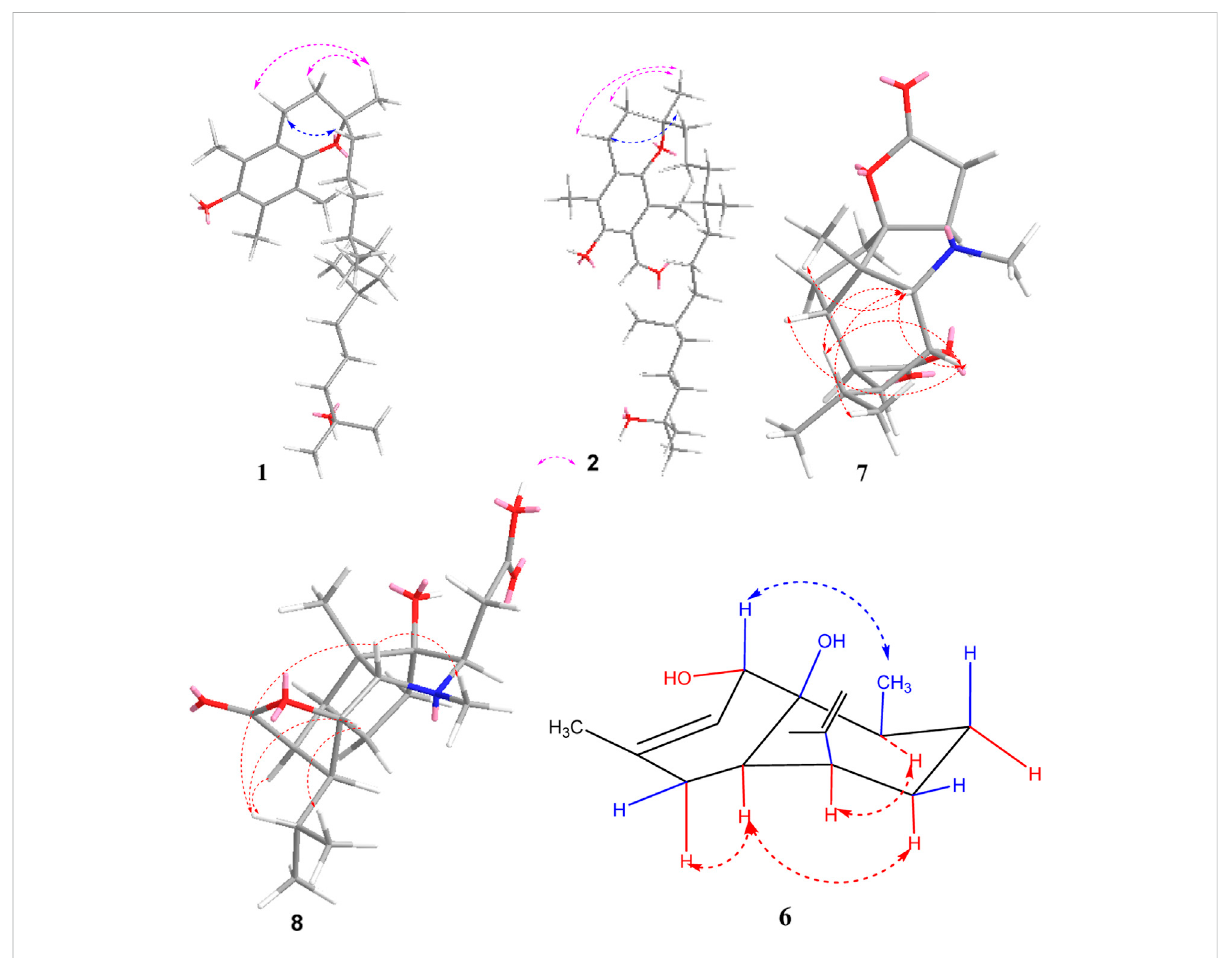
FIGURE 3 Key NOESY correlations of compounds 1 – 2 , 6-8